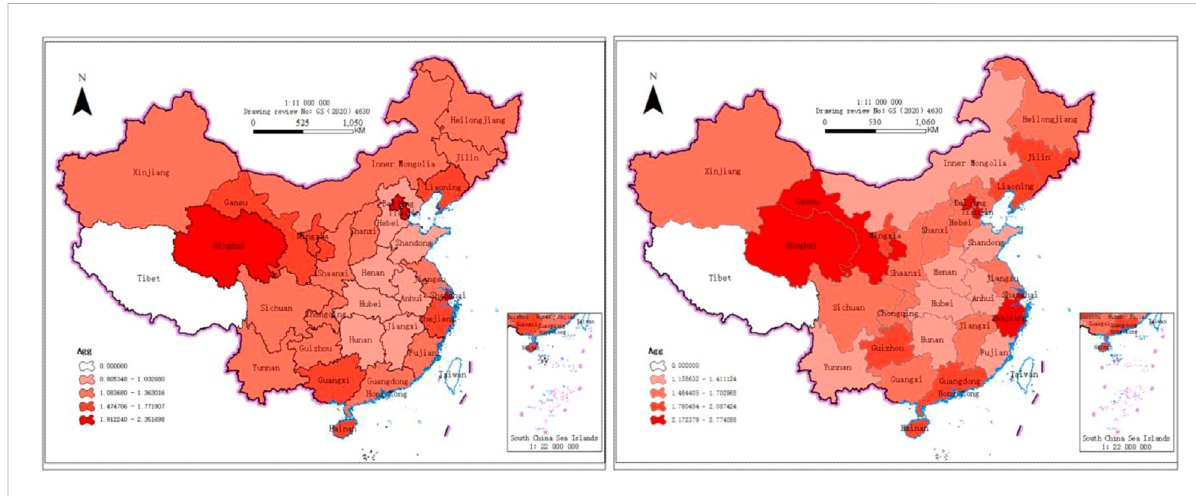
FIGURE 3 Theaveragelevelof fi nancialagglomerationineachprovincefrom2006to2020(left)andthe fi nancialagglomerationlevelin2020byprovince